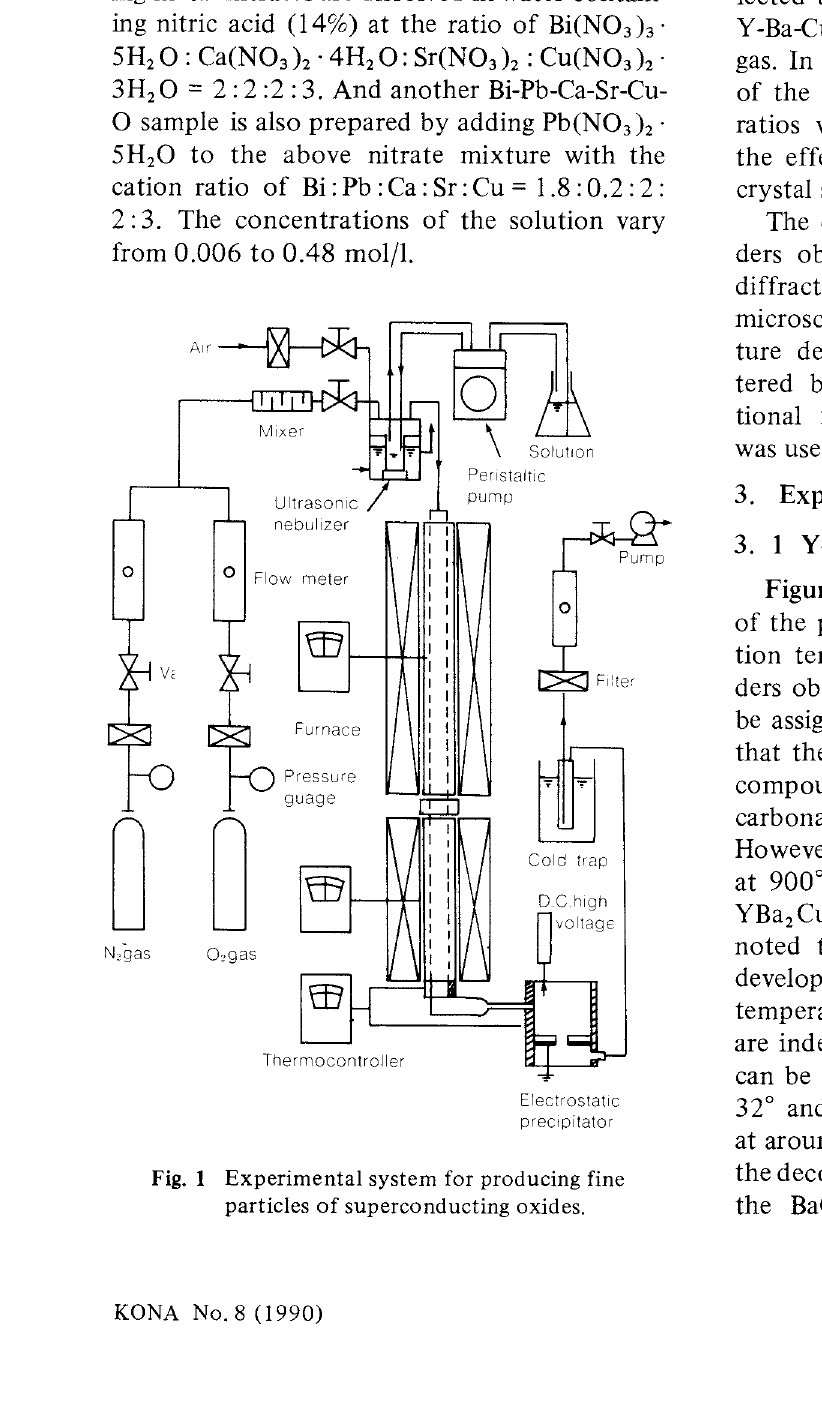
Fig. I Experimental system for producing fine particles of superconducting